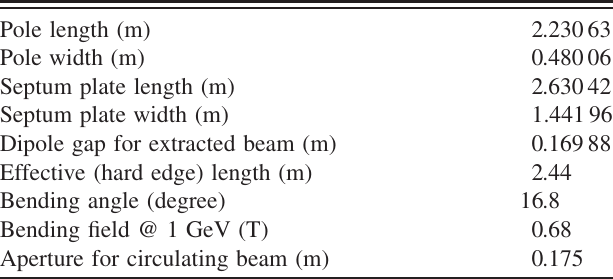
TABLE I. ELS main design parameters